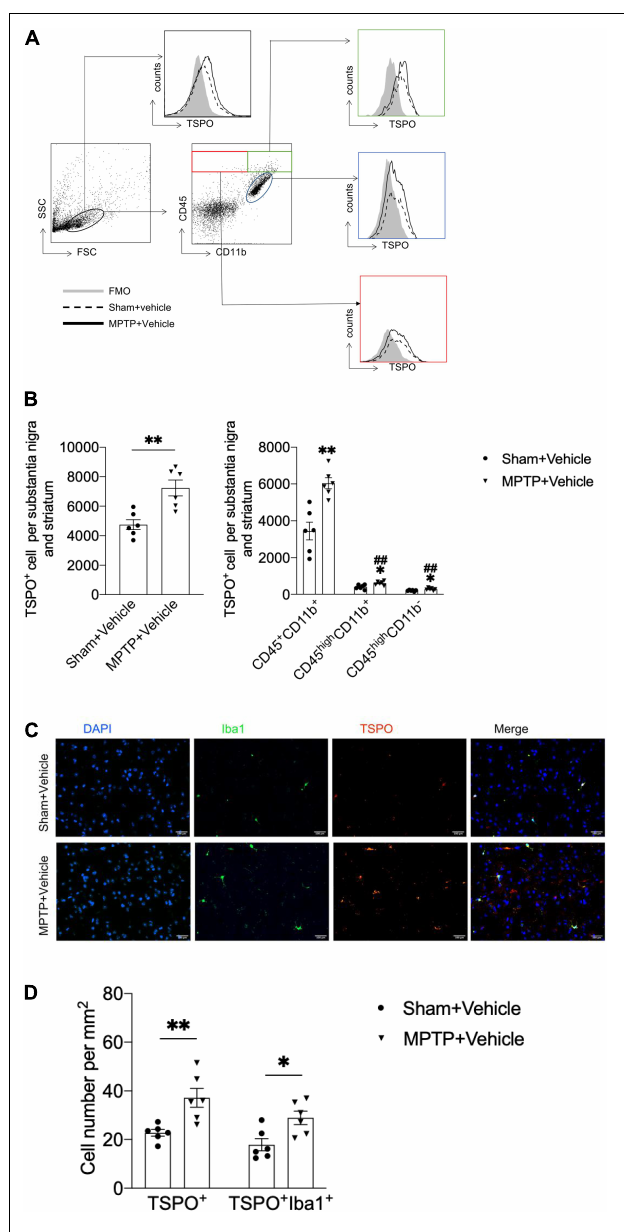
FIGURE 1 | Upregulation of TSPO expression in the brains of MPTP-treated mice. On day 7 after saline or MPTP treatment, single-cell suspensions were prepared from substantia nigra and striatal tissues. (A) Flow cytometry plots showing gating of CD45 + CD11b + , CD45 high CD11b + , and CD45 high CD11b − cell subsets expressing TSPO. (B) Bar graph showing the expression of TSPO in the indicated cell subsets. T = 3.916, DF = 10, P = 0.003